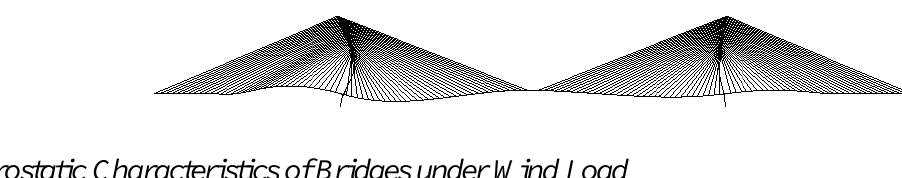
Figure 17. Elasto-plastic buckling mode of cable-stayed